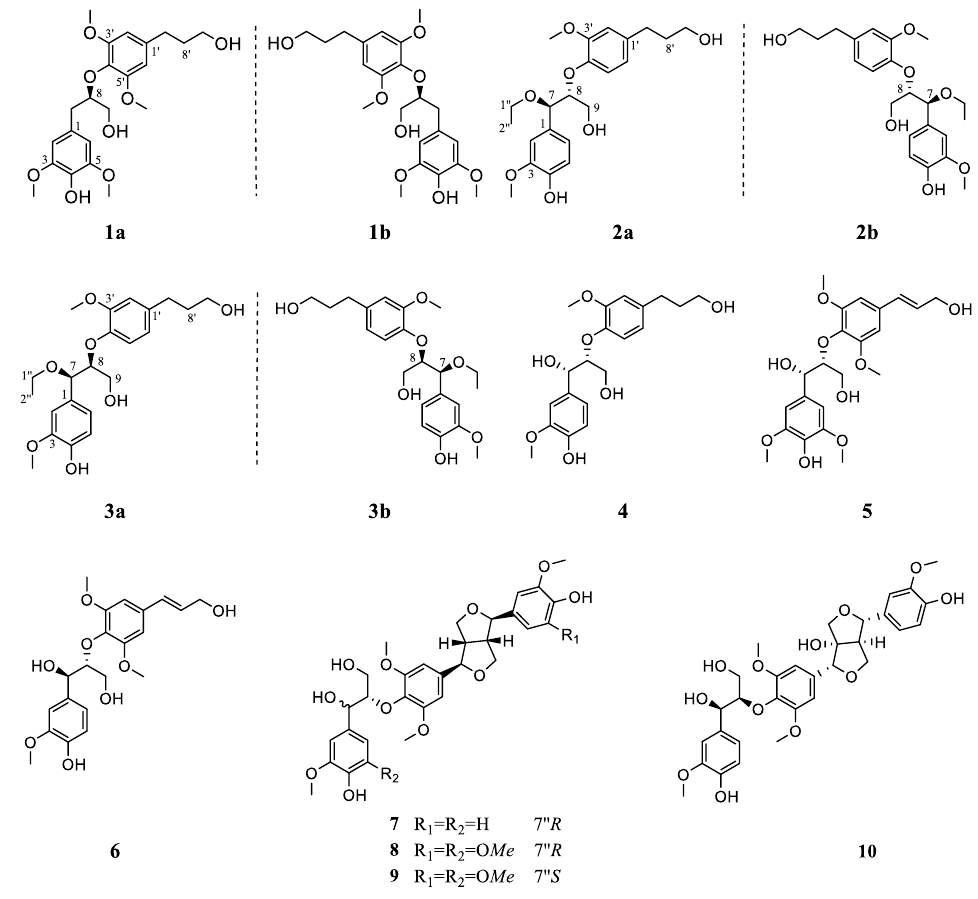
Figure 1. Chemical structures of compounds 1 – 10 . Table 1. 1 H NMR (400 MHz) and 13 C (125 MHz) data for compounds 1 – 3 ( δ H in ppm, J in